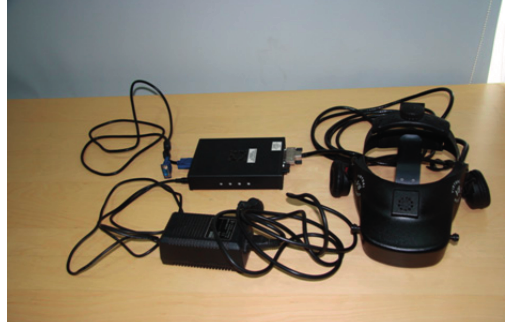
Figure 4. V8 head mount display.